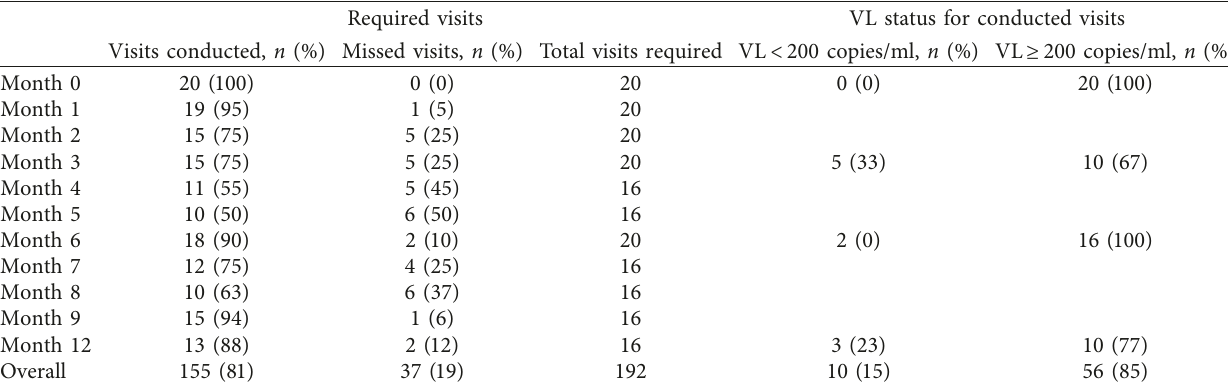
Table 5: EAC visit attendance for participants with VL ≥ 200 copies/ml at enrolment. Required